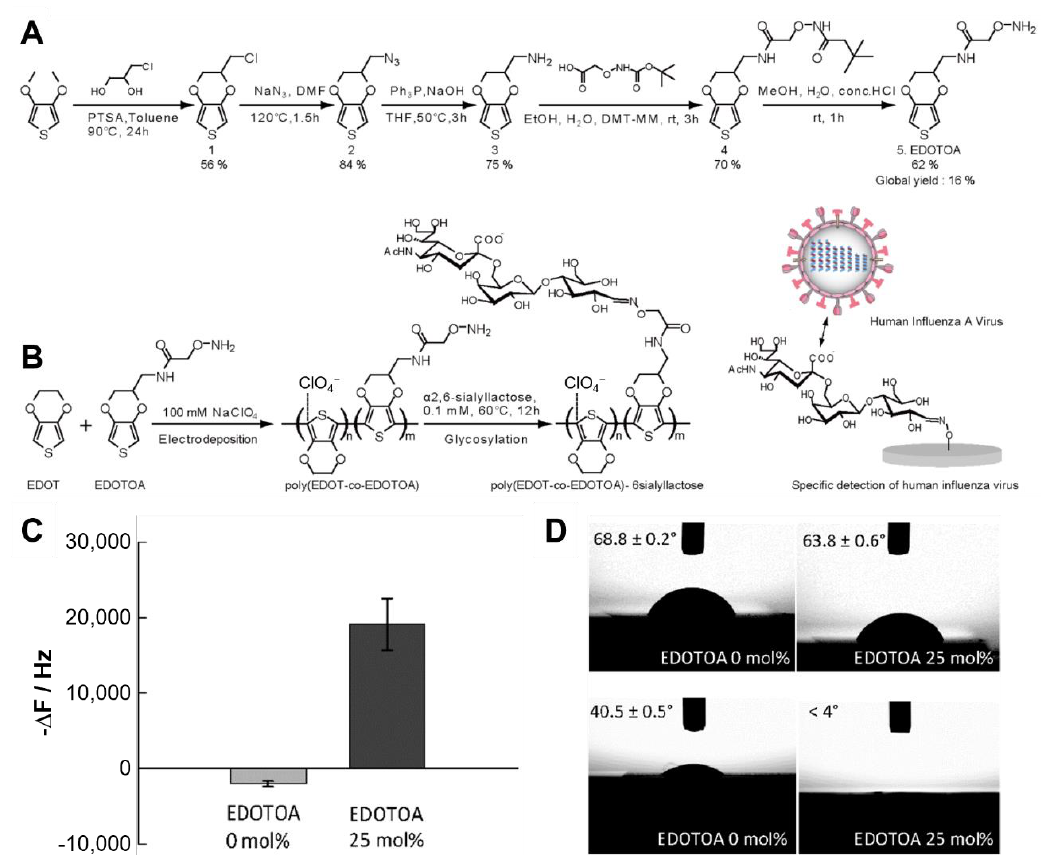
Figure 5. Synthetic route for the preparation of sialyllactose-grafted monomer ( A ). Scheme of the copolymer synthesis and glycosylation ( B ). Changes in the surface mass ( C ) and wettability ( D ) of the functionalized polymer upon glycosylation. Adapted with permission from reference [83]. Copyright 2017 American Chemical Society.